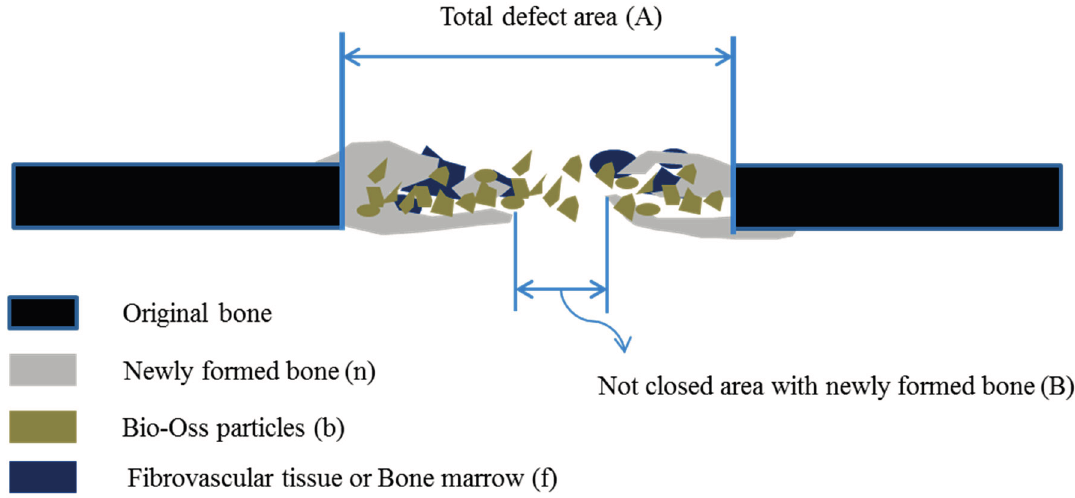
Figure 10. Schematic drawing of a calvarial osteotomy defect Amounts of new bone (%) as a percentage of augmented area = n/(n + b + f) × 100 (where n is newly formed bone, b is Bio-Oss ® particle, and f is fibrovascular tissue or bone marrow), Defect closure (%) = (A − B)/A ×